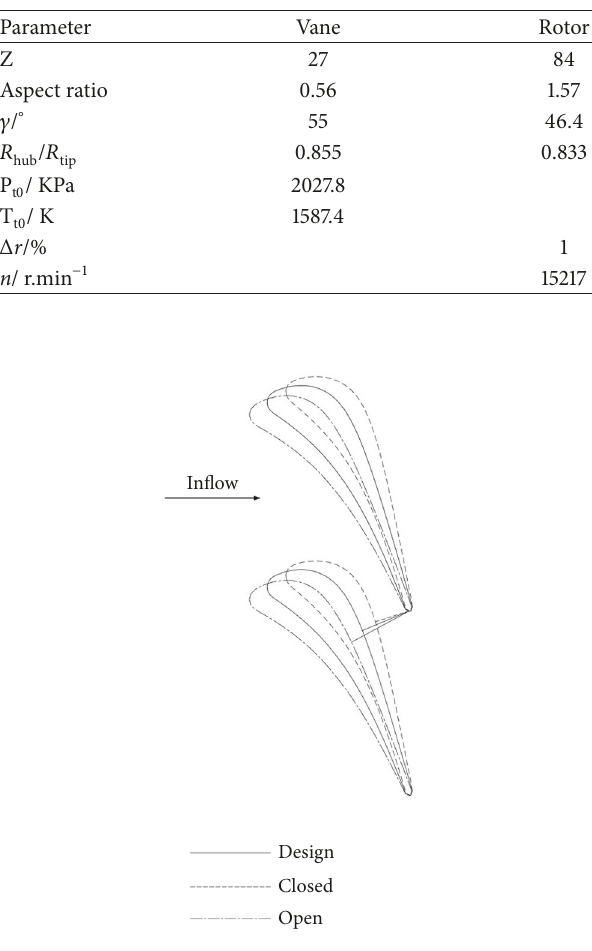
Figure 1: Variable vane